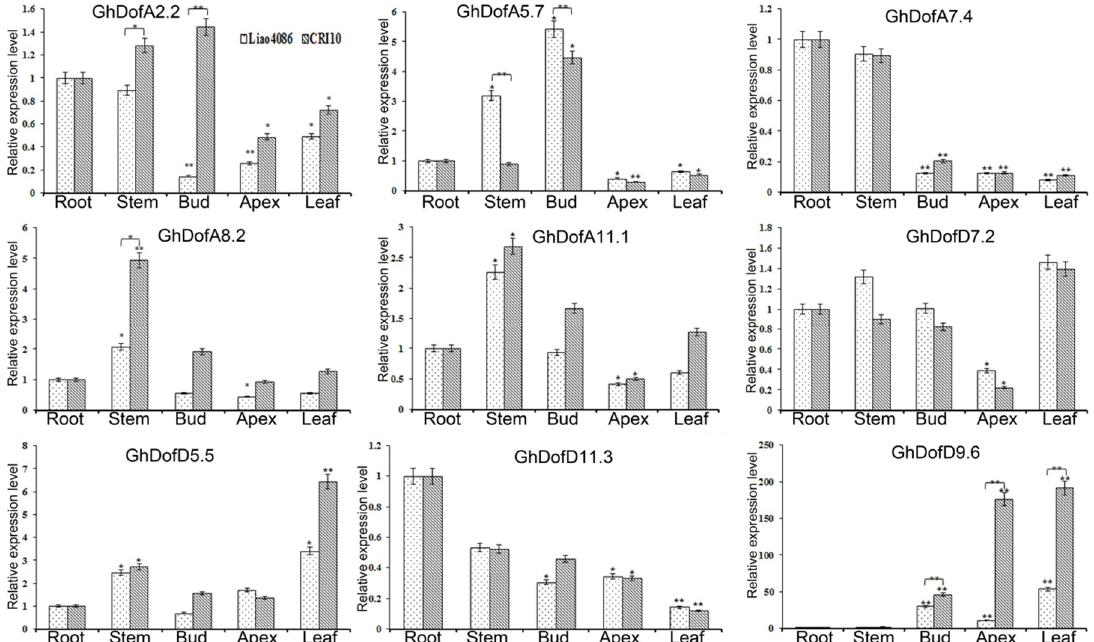
Figure 4. GhDof relative expression levels in the root, stem, bud, shoot apex, and leaf. The X -axis indicates tissues, and the Y -axis indicates relative expression values. The Y -axis indicates the relative expression level. The threshold cycle (Ct) values of all of the genes were normalized to the internal reference gene—a house-keeping gene ( GhHis ); the relative expression level was calculated by the 2 − ∆∆ C t method. The bars indicate the standard deviation (SD). The brackets indicate the comparison between CCRI10 and Liao4086. * indicates a significant difference at the p < 0.05 level. ** indicates an extremely significant difference at the p < 0.01 level.